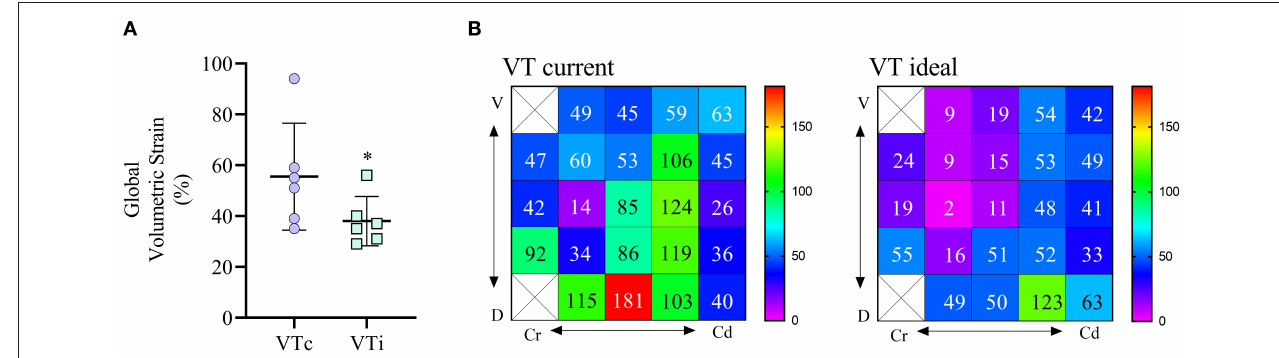
FIGURE 6 | Global and regional volumetric strain calculated for six obese dogs undergoing anesthesia for computed tomography (CT) scan. (A) Global volumetric strain in dogs receiving a tidal volume based on current (VTc) and ideal (VTi) body weight. * p < 0.05. (B) Regional strain 2D maps are shown for one dog receiving VT based on current body weight (left matrix) and based on ideal body weight (right matrix). Values are percentages, the void squares indicate that no lung intersection between ventrodorsal and craniocaudal directions was found in these ROIs.